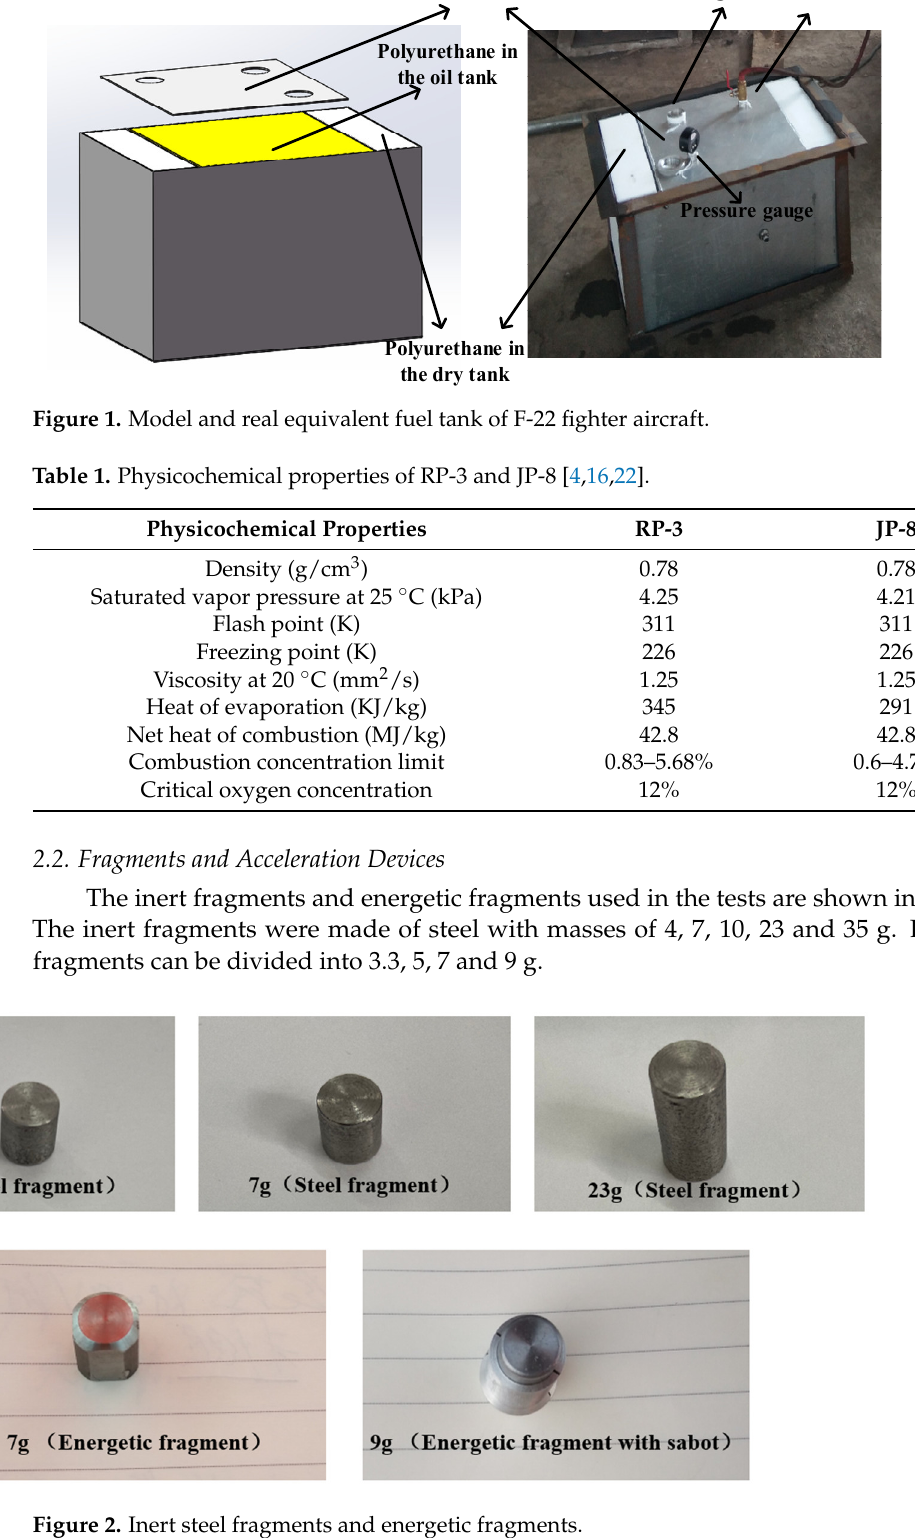
Figure 3. Three fragment acceleration devices. ( a ) A ballistic gun; ( b ) a 37 mm gun; and ( c ) a two- stage light-gas gun. 2.3. Experimental Principles The test principle is shown in Figure 4, which is composed of the fragment accelera- tion device, fragments, a sabot recycler, a velocity probe and a fuel tank. The sabot recycler was used to recycle the separated sabots after acceleration. The impact speeds of frag- ments were measured by the velocity probe in front of the tank. The damage to the fuel tank caused by fragments was recorded by a high-speed camera so the damage process and mechanism could be explored.